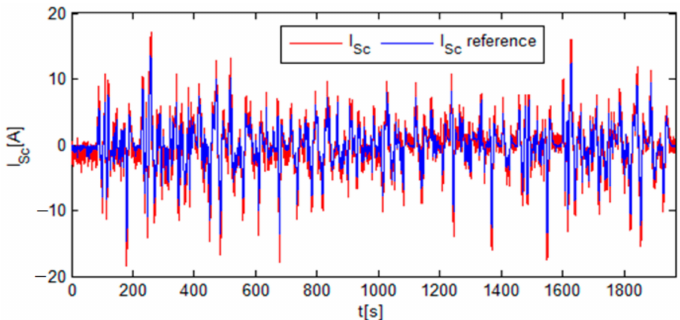
Figure 32. Sc current control result.